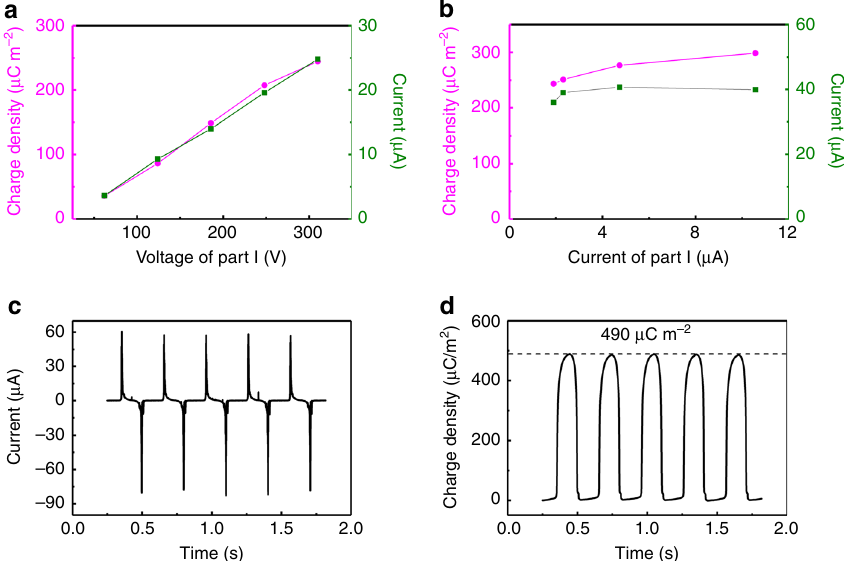
Fig. 4 Triboelectric nanogenerator performance and part I output. a , b Show the current (green) and effective charge density (magenta) of self-improving triboelectric nanogenerator (SI-TENG) with the voltage and current of part I. c , d Show the output current and effective charge density of the SI-TENG, respectively, after further increasing the voltage of part I by the charge injection